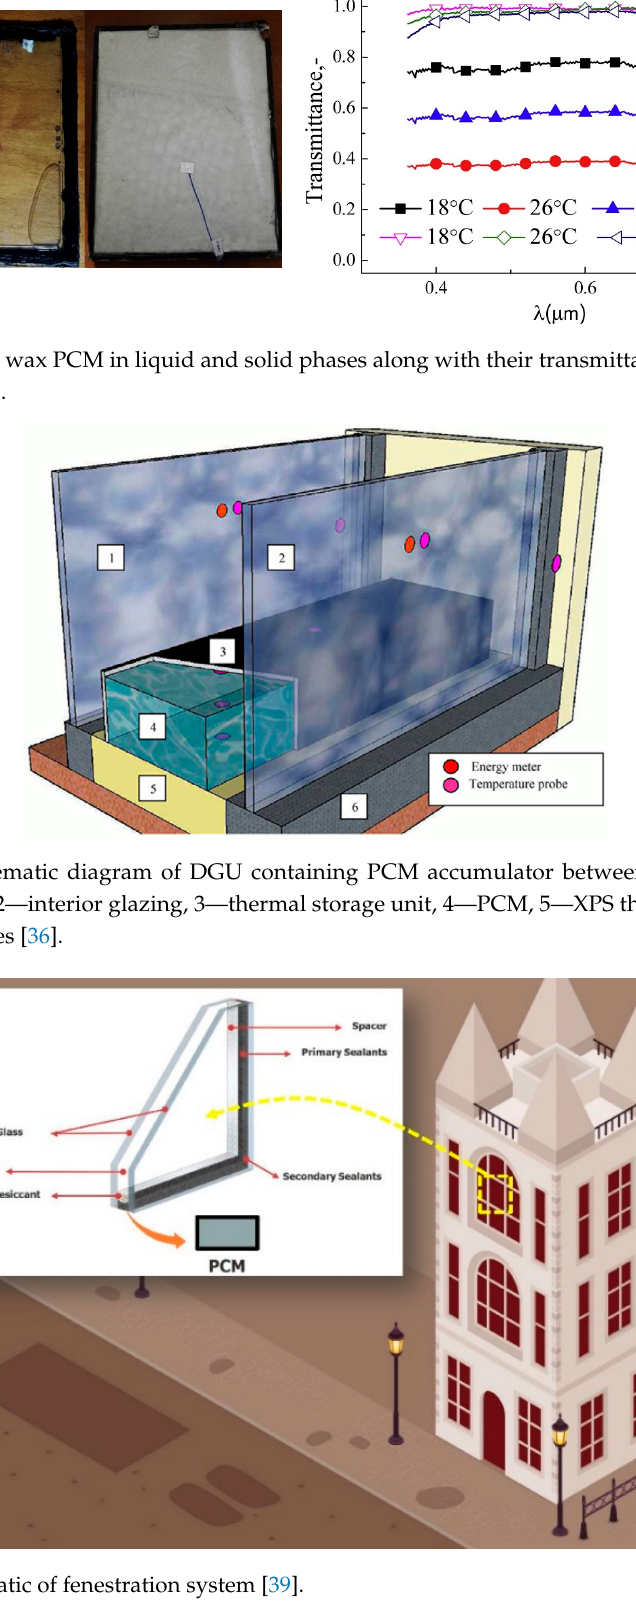
Figure 11. Schematic of DG system [40]. PCMs have also been used in triple-glazing (TG) and quadruple-glazing (QG) win- dows. In Nanjing, China (Cfa)., Li et al. [42] empirically and mathematically assessed the cooling and heating energy performance of a PCM-TG window. The numerical simula- tions were carried out utilizing ANSYS Fluent. The PCM material paraffin MG29 with an MT of 27–29 °C was inserted in the outside gap cavity space of the TG window, while the inner cavity was filled with air compared to a TGU and PCM-DGU with an entirely air- filled cavity. Using the PCM-TG window prevents overheating during the cooling time, as demonstrated by the findings. In a typical sunny summer day, comparing the PCM-TG window to the PCM-DG window and hollow TG window, 21.30% and 32.80% reductions in energy consumption were noted. Wieprzkowicz and Heim [43] evaluated the cooling and lighting energies, glare effect, and thermal and optical discomforts of a PCM-TG win- dow in Lodz, Poland (Dfb), by means of a numerical and experimental investigation. Five PCMs of paraffin RT18HC, RT22HC, RT25HC, RT28HC, and RT31 were chosen to fill the outer cavity space of the glazing system, while Argon gas was used to fill the interior cavity space. The acquired results indicate that there is no optimal unit type of PCM for